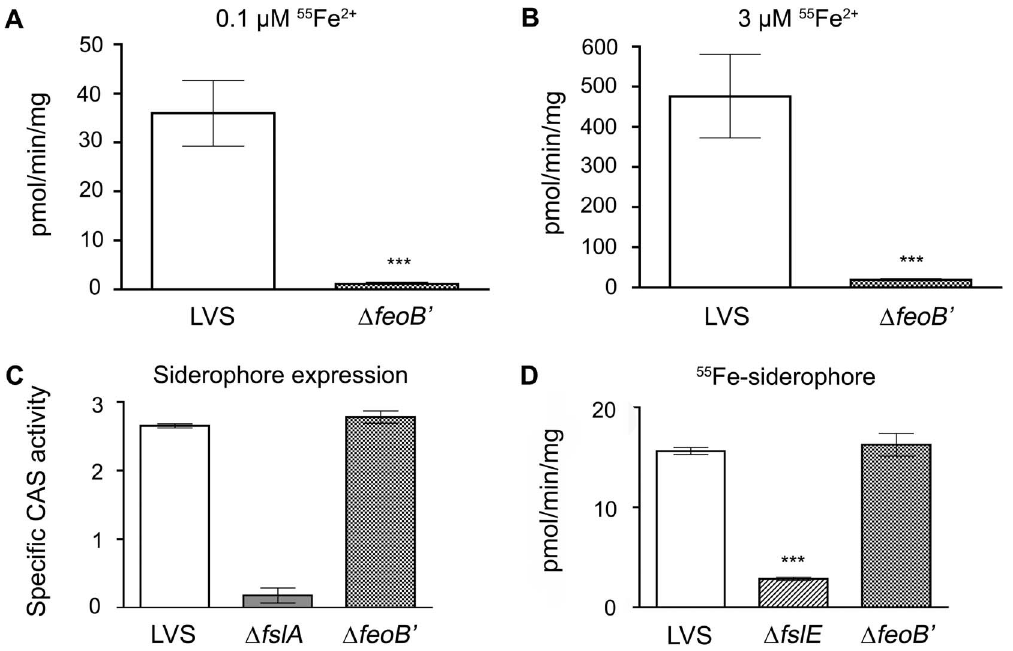
Figure 2. LVS D feoB 9 is defective for ferrous uptake but is capable of siderophore production and utilization. A and B, 55 Fe ferrous iron uptake. LVS and D feoB 9 strains were grown overnight to mid-logarithmic phase in iron-limiting liquid che-CDM and rates of ferrous iron uptake were determined at 0.1 and 3 m M [ 55 Fe 2 + ] in the presence of ascorbate. C, Siderophore production. Culture supernatants of LVS, D fslA , D feoB 9 strains grown overnight under iron-limitation were tested in the CAS assay and siderophore activity was normalized to OD 600 . D, Siderophore-mediated 55 Fe uptake. 55 Fe-bound siderophore was incubated with bacteria grown in iron-limiting che-CDM and the rate of 55 Fe uptake was determined. Values were expressed as the means 6 S.D. Significance was calculated relative to LVS values. ***p , 0.001.